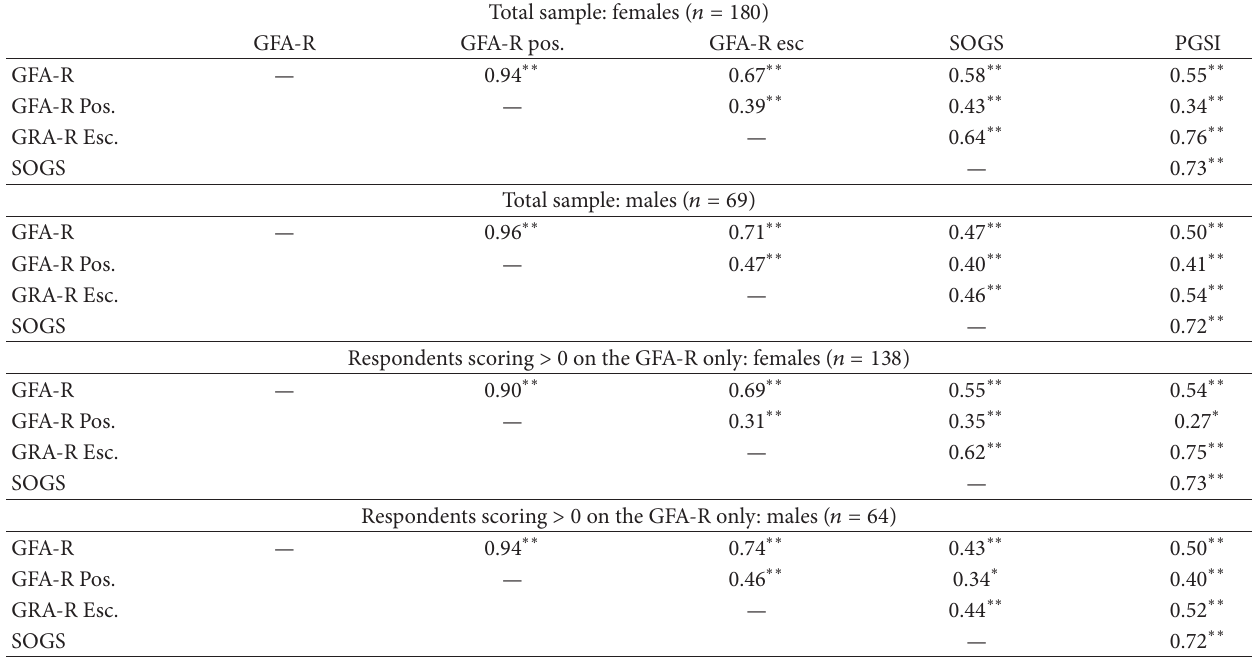
who scored above 0 on the